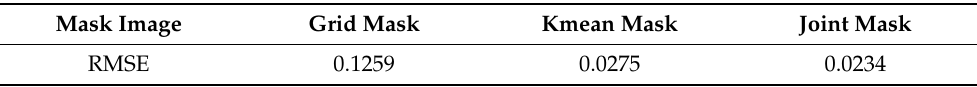
Table 5. Absolute trajectory error obtained by the DGFlow-SLAM system after removing dynamic points using three mask images separately